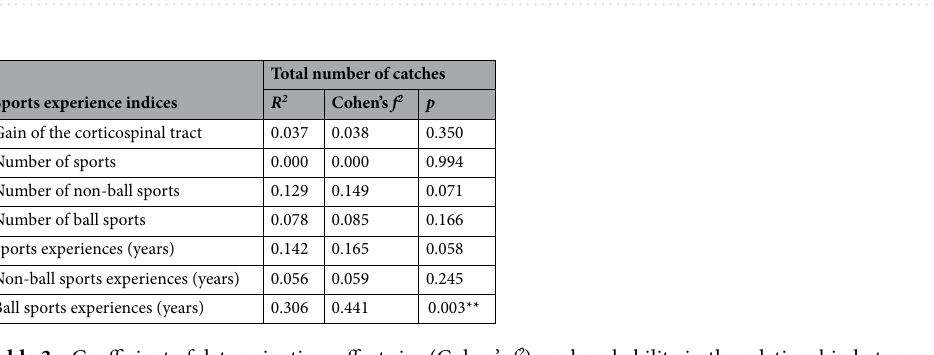
Table 3. Coefficient of determination, effect size (Cohen’s f 2 ), and probability in the relationship between indices of sports experiences and total number of catches. ** p <